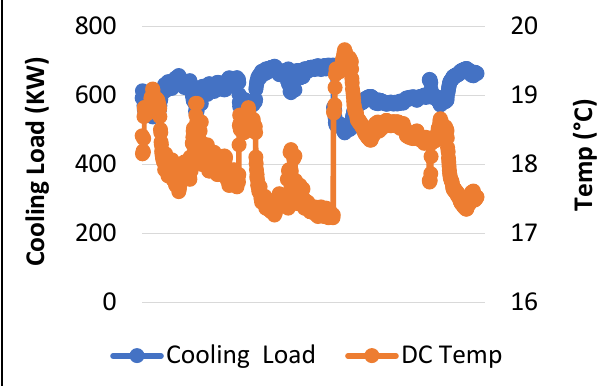
Figure 8. Actual data DC cooling load vs